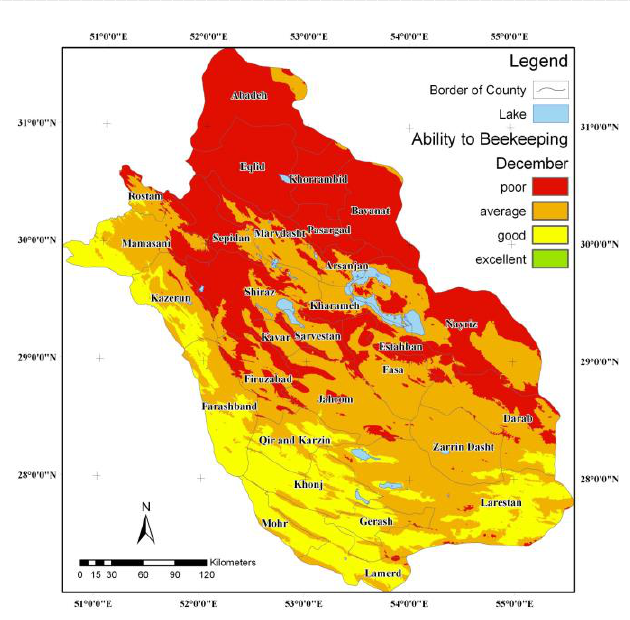
Fig. 9. Suitability of climate conditions for beekeeping in December.